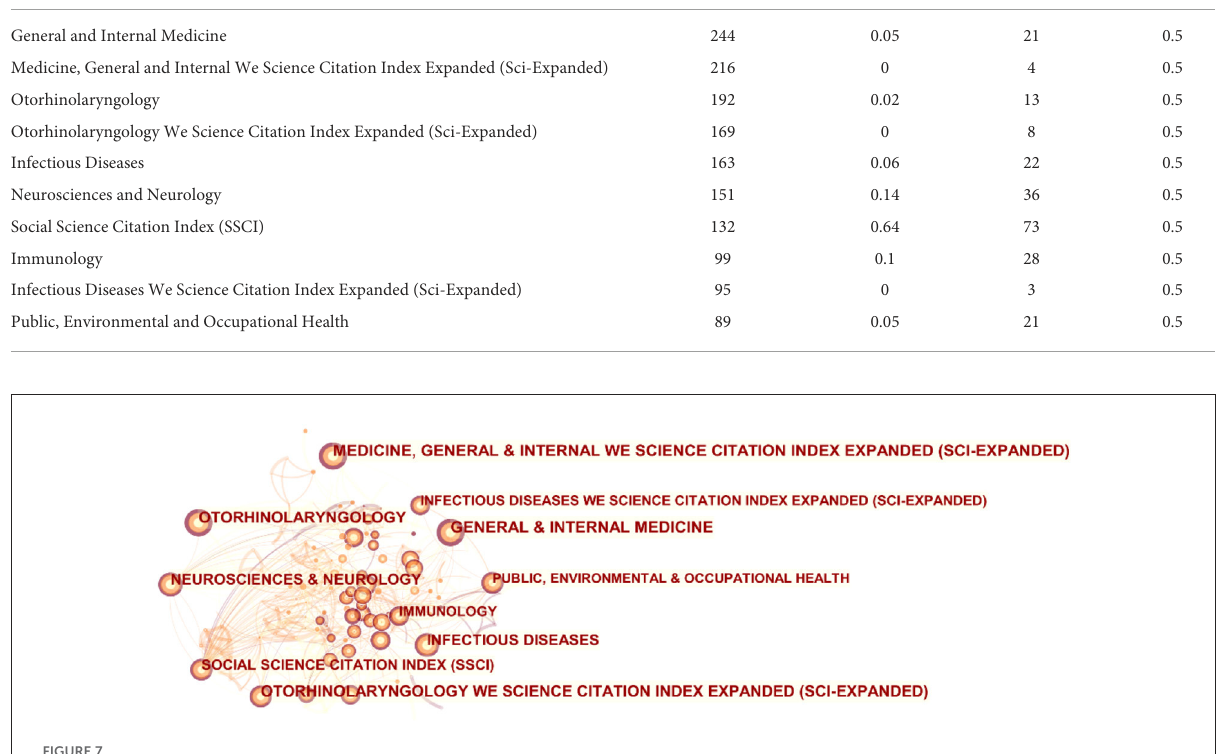
FIGURE7 Visual analysis of network diagram in COVID-19-related otorhinolaryngology areas of